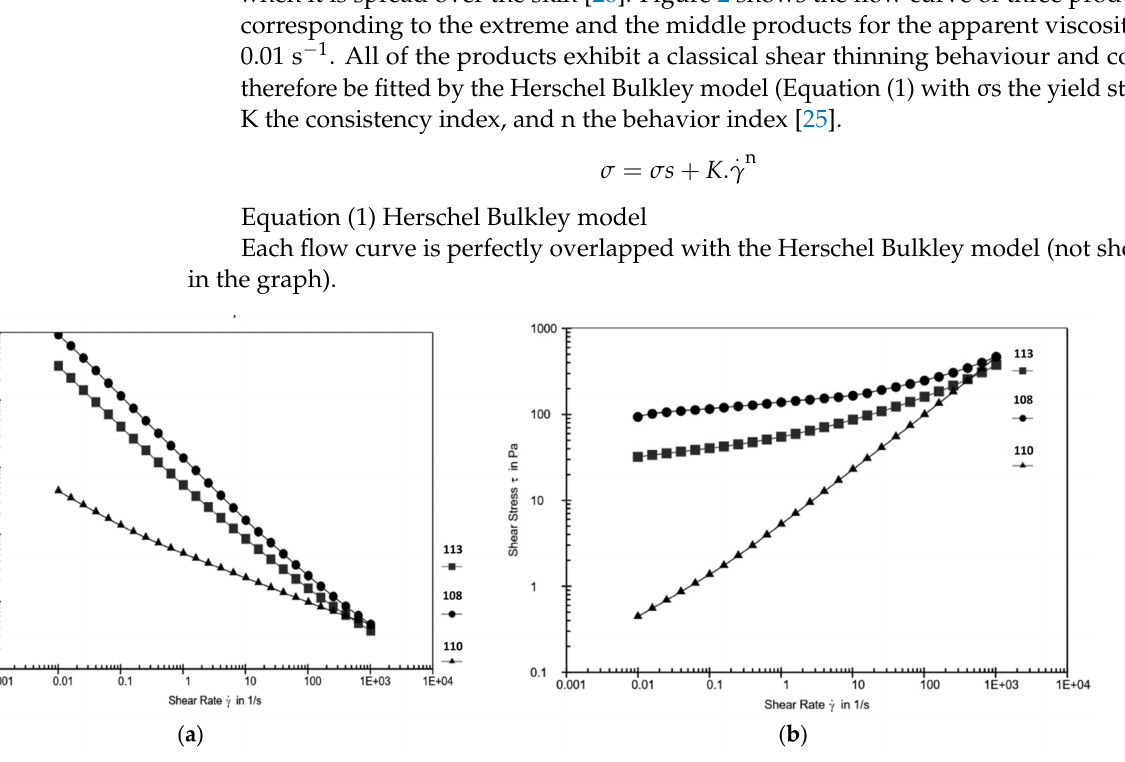
Figure 2. Viscosity ( a ) and flow ( b ) curves of three products representing the extreme 0 (109 and 107) and the middle (103) of